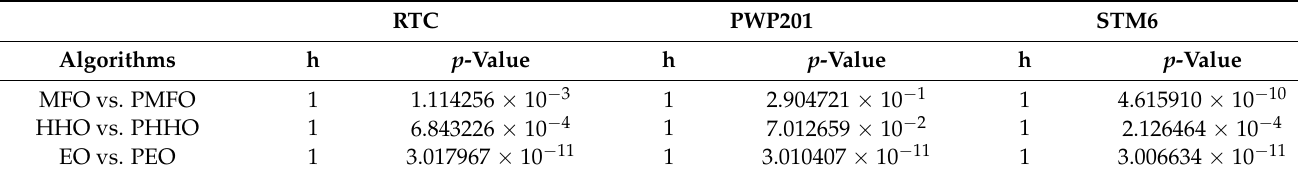
Table 11. Comparison between the proposed with the others under the Mann–Whitney U test.